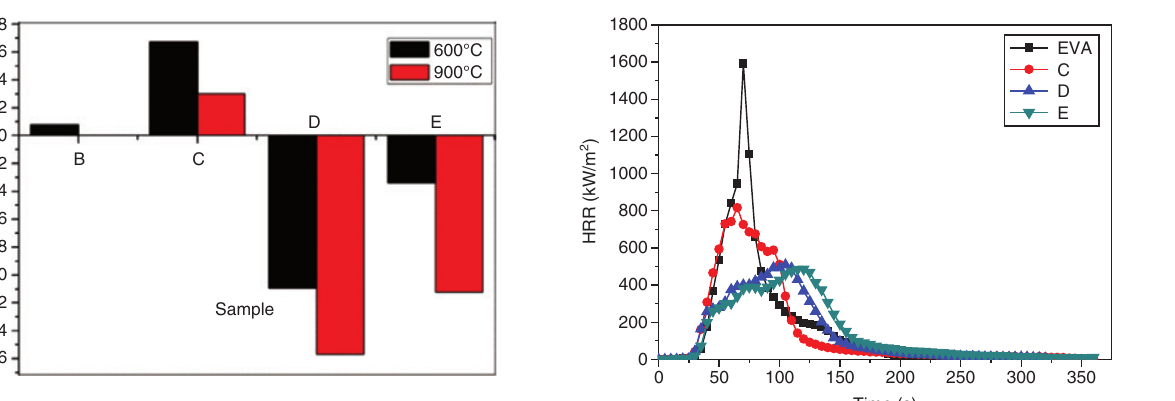
Dimensional changes of the other residues are shown in Figure 1. C600 and C900 displayed expansibility, while samples D and E fired at 600 ° C and 900 ° C showed sig- nificant contraction.